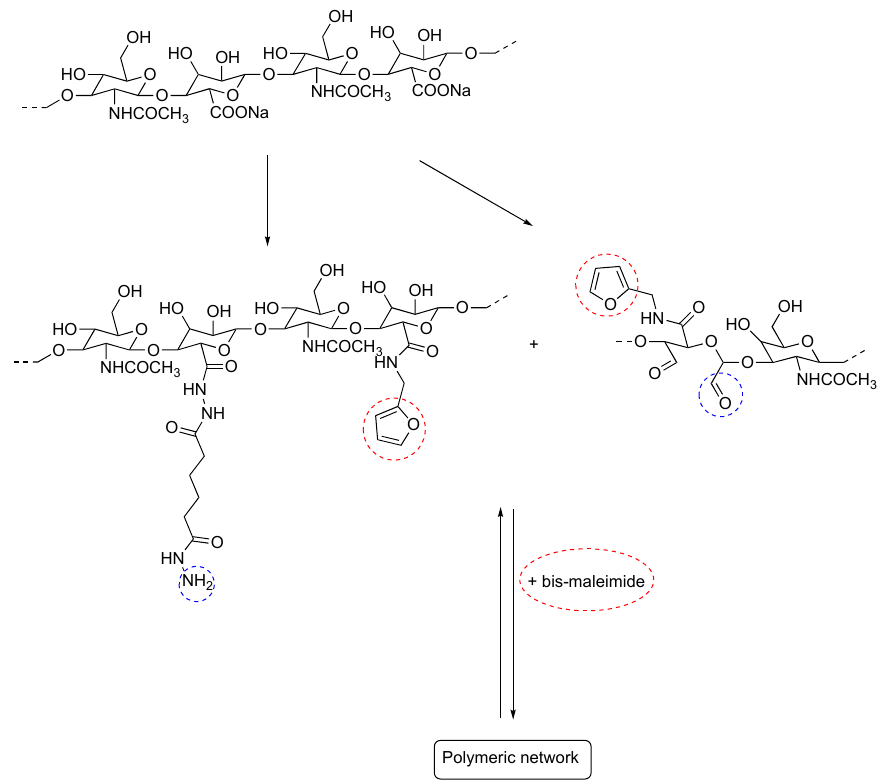
Figure 6. Double cross link network based on Diels-Alder and acylhydrazone reversible chemistry. Adapted and re-drawn from [9].